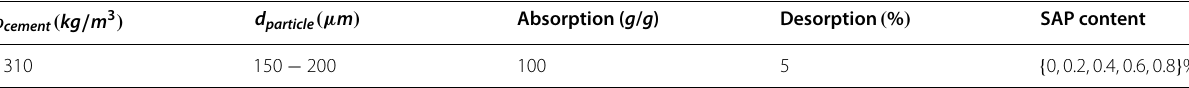
Table 1 Properties of SAP-contained mortar mixtures.